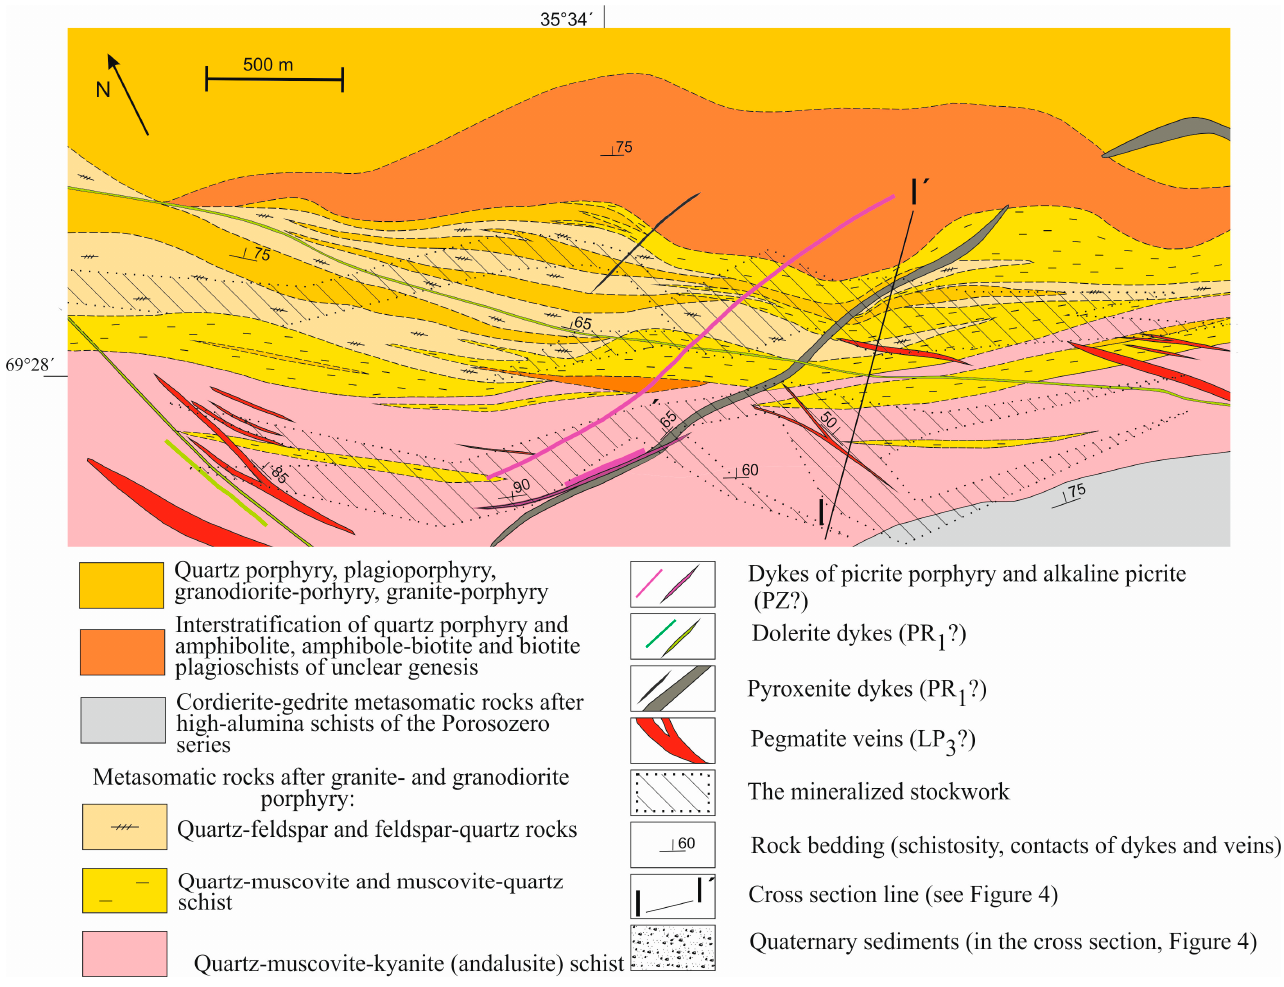
Figure 3. Schematic geological map of the Pellapahk Cu-Mo deposit, modified from reference [9].